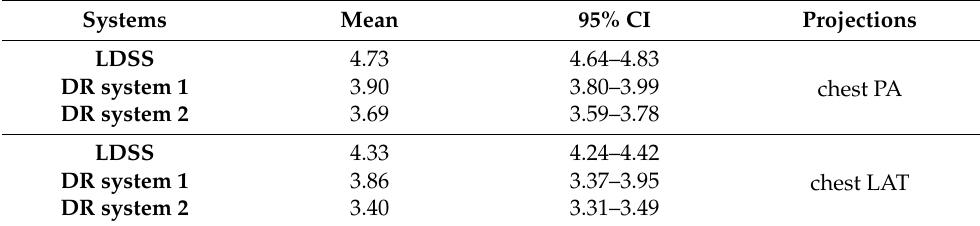
Table 10. Means of VGA value for all imaging systems for the chest PA/LAT